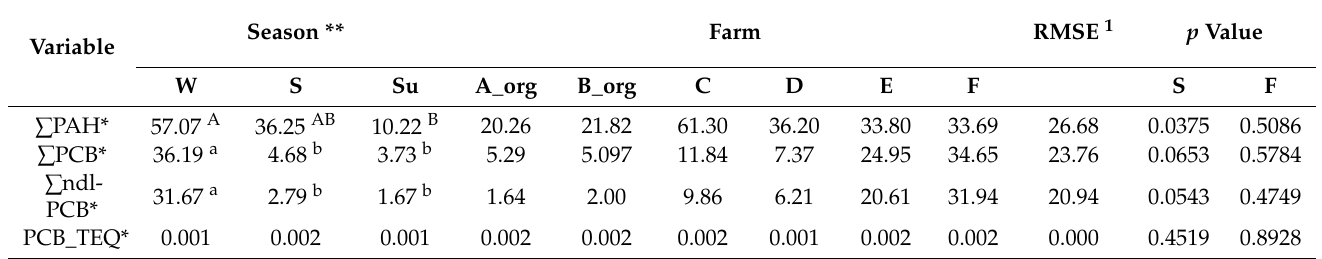
Figure 3. Box plot of contaminants in cheese samples versus seasons. The * symbols refer to the values normalized per gram lipid amount. Table 5. Influences of the production season and farm on ∑ PAH*, ∑ PCB*, ∑ ndl-PCB* and PCB_TEQ* (ng/g fat). The * symbols refer to the values normalized per gram lipid amount